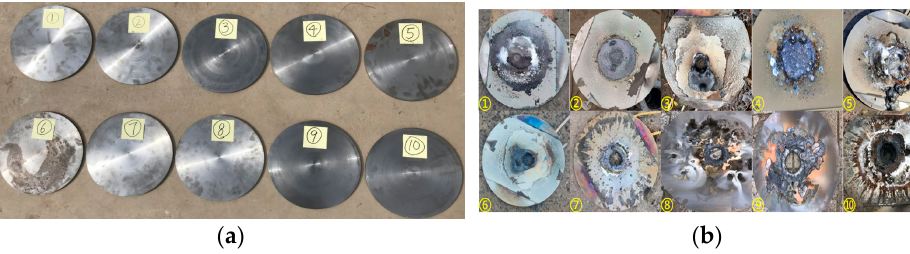
Figure 8. The state of the steel targets before and after the tests. ( a ) Before tests, ( b ) After tests. The thickness of each Q235 steel target was 10 mm, and the diameter was 30